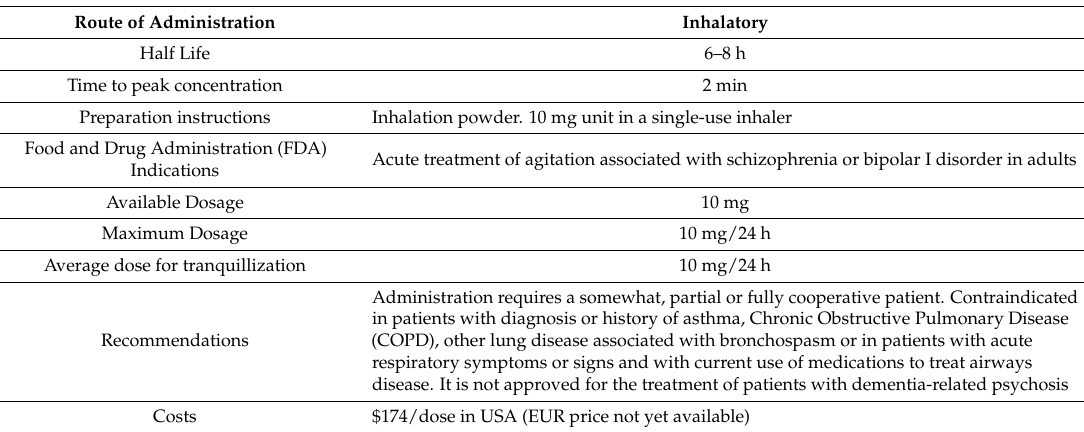
Table 1. Characteristics of inhaled First Generation Antipsychotic (FGA)